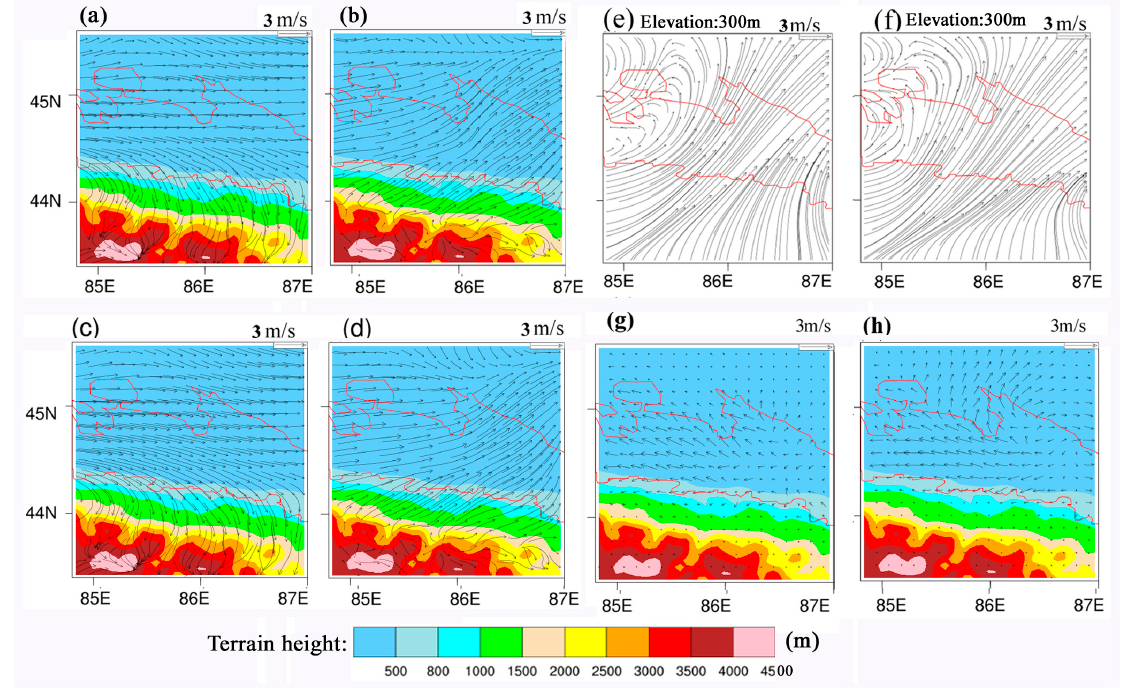
Figure 10. The mean diurnal W S and W D patterns (mean wind speed and direction at a height of 10 m during the daytime and nighttime) in the mod , non-oasis and non-mountain simulations and the differences between the mod and non-oasis simulations. ( a ) Daytime Ws and W D from the mod simulation; ( b ) nighttime Ws and W D from the mod simulation; ( c ) daytime Ws and W D from the non-oasis simulation; ( d ) nighttime Ws and W D from the non-oasis simulation; ( e ) daytime Ws and W D from the non-mountain simulation; ( f ) nighttime Ws and W D from the non-mountain simulation; ( g ) daytime Ws and W D difference between the mod and non-oasis simulations; ( h ) nighttime Ws and W D difference between the mod and non-oasis simulations. The red line represents the border of the oasis.